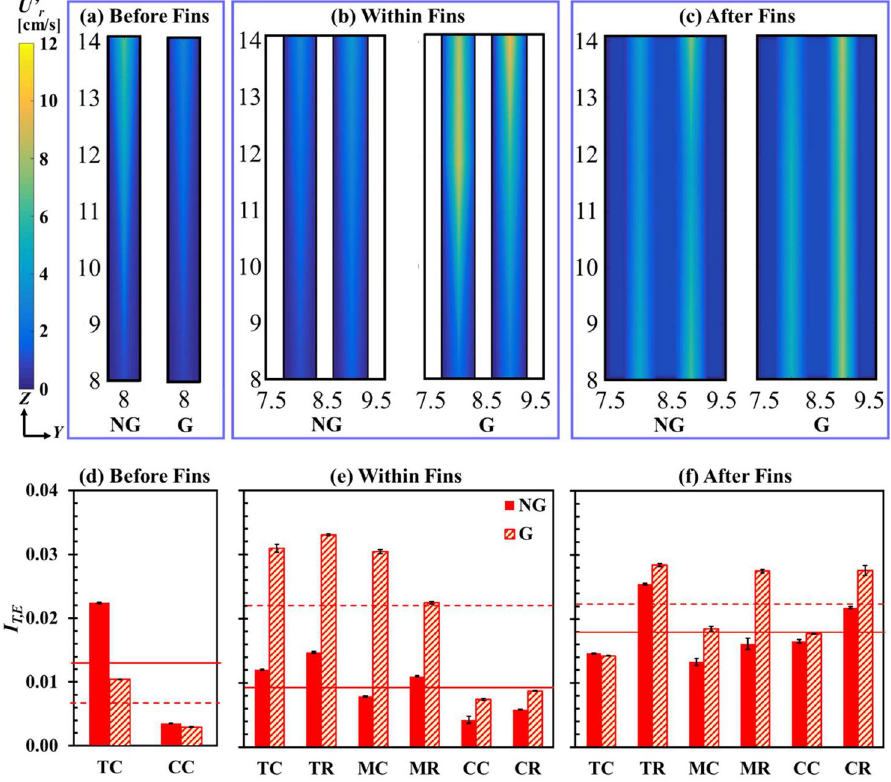
Figure 9. 2D contours of SPTV detected particle velocity fluctuation U ’ r on Y – Z plane (top row) and SPTV measured equivalent turbulence intensity I T,E (bottom row) for NG and G at positions ( a , d ) before fins, ( b , e ) within fins and ( c , f ) after fins. Note: the horizontal solid line indicates average value for NG whereas dashed line represents average value for